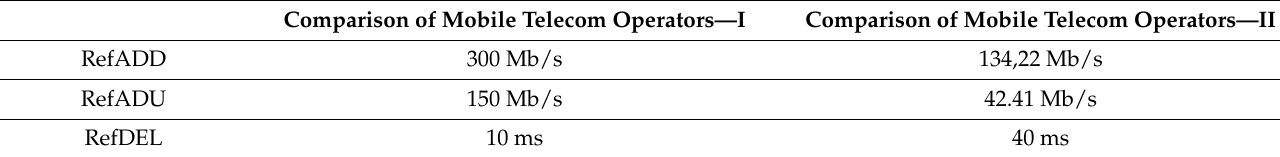
Table 4. Reference values for the MDUA item (Ref).